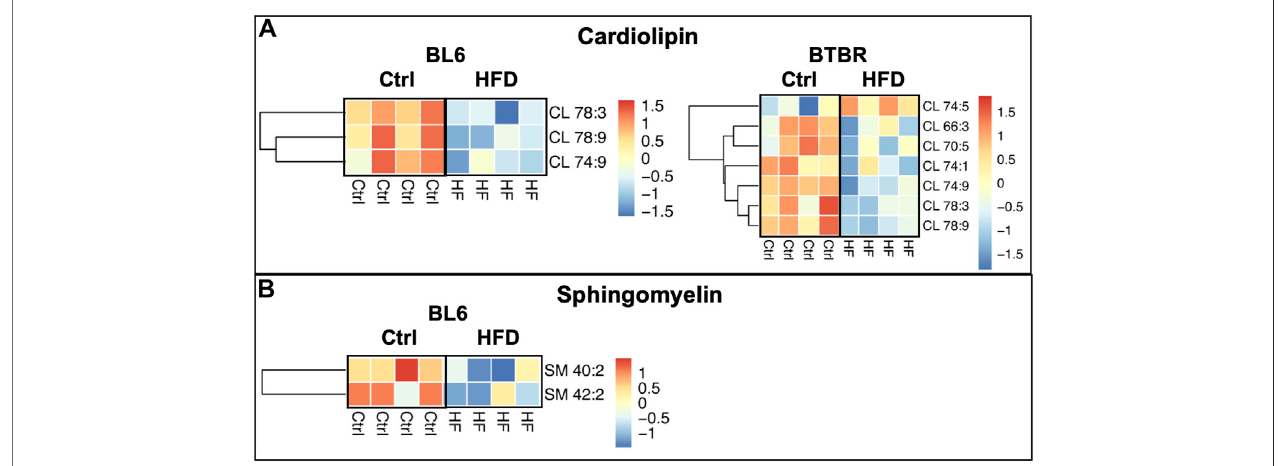
FIGURE 6 | Heat maps of BL6, BTBR, and BKS sciatic nerve plasmalogens and lysophospholipids. (A) HFD BL6 and BTBR mice show a global decrease in plasmenyl-phosphatidylethanolamine (plasmenyl-PE) whereas BKS mice have an increase in plasmenyl-PE. (B) Lysophosphatidylcholine (LPC) species were also signi fi cantly decreased in HFD BL6 and BTBR mice. (C) LPE species were decreased exclusively in the sciatic nerve of HFD BL6 mice only. t -test, p -value < 0.05.